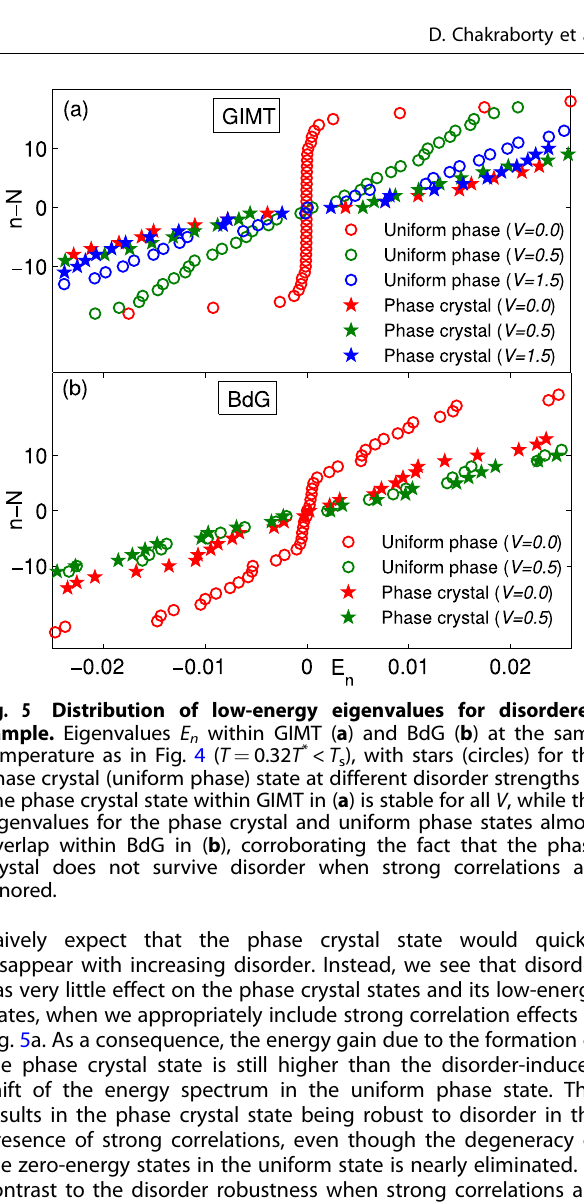
Fig. 5a. As a consequence, the energy gain due to the formation of the phase crystal state is still higher than the disorder-induced shift of the energy spectrum in the uniform phase state. This results in the phase crystal state being robust to disorder in the presence of strong correlations, even though the degeneracy of the zero-energy states in the uniform state is nearly eliminated. In contrast to the disorder robustness when strong correlations are appropriately included, we fi nd in Fig. 5b that the BdG eigenspectra of the uniform and phase crystal states start to overlap even for small disorder. As a result, the formation of a phase crystal state does not reduce the total free energy and thus the phase crystal state is destroyed even at weak disorder when strong correlations are ignored.